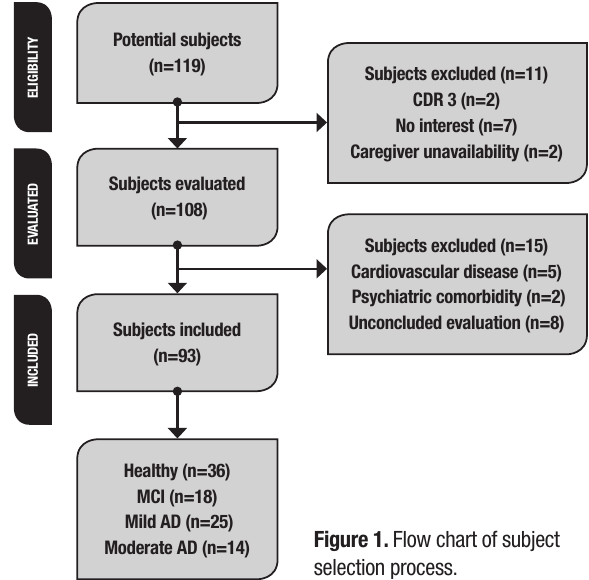
Figure 1. Flow chart of subject selection